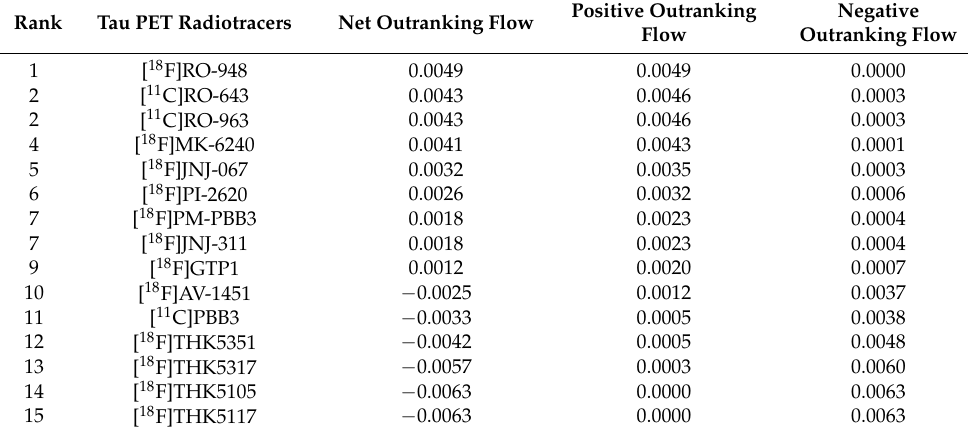
Table 5. Sensitivity analysis results with fuzzy